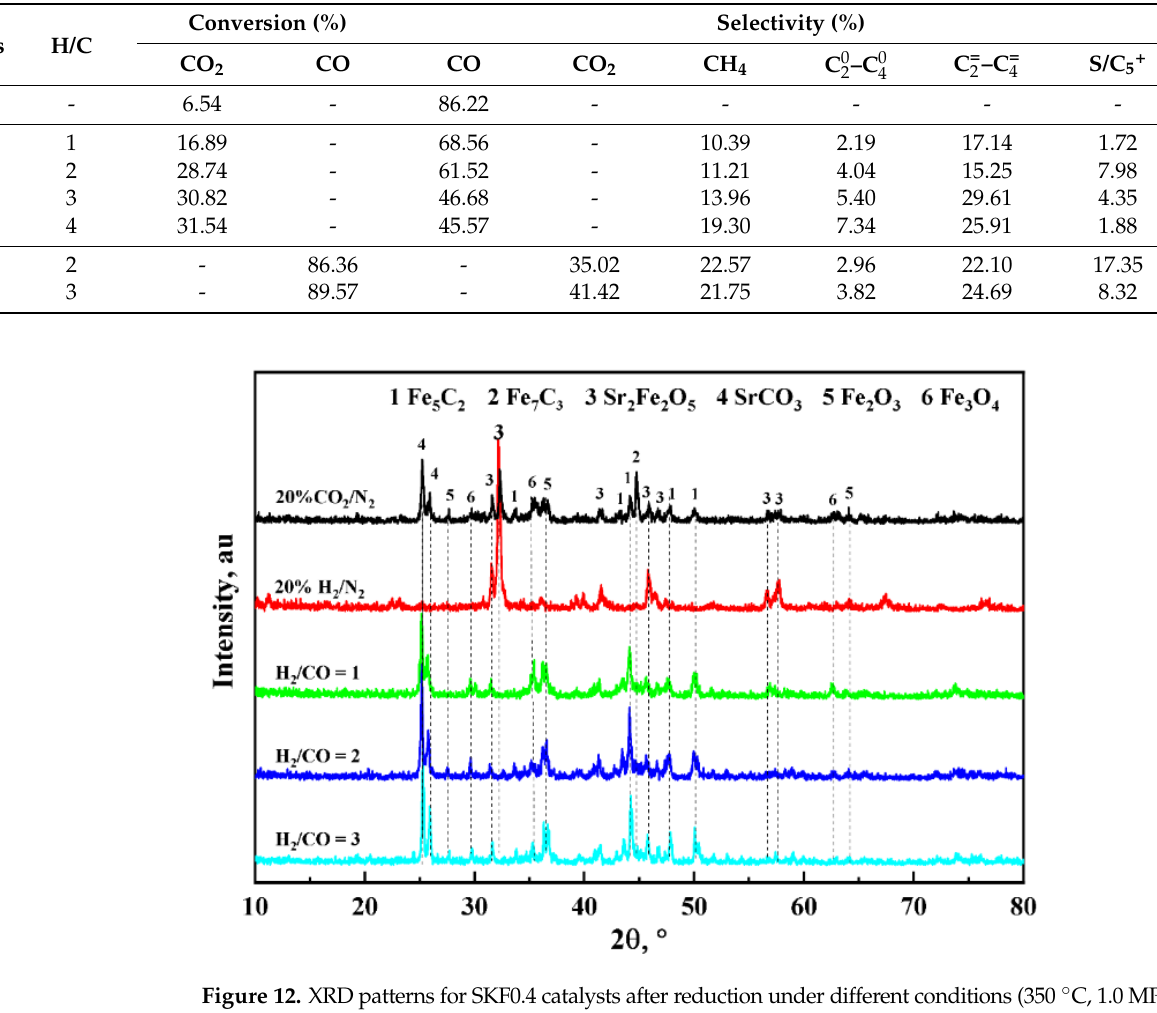
Table 2. CO 2 /CO conversion and product distribution using SKF0.4 under different conditions (350 ◦ C, 1.0 MPa).